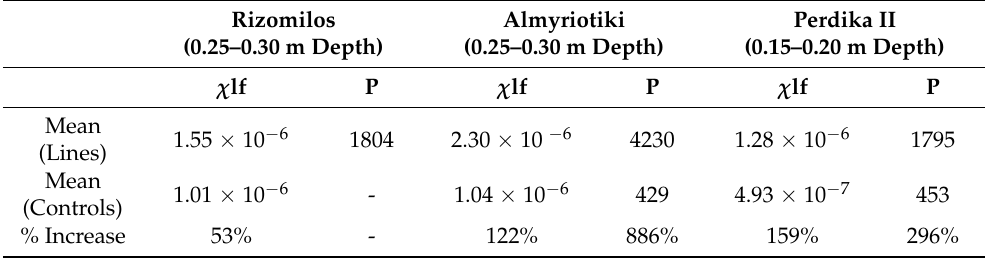
Table 3. Mean (average) values and % increase of magnetic susceptibility ( χ 10 − 6 m 3 kg − 1 ) and phosphate (P, ppm) at the three sites at the sampling depth of the exploratory